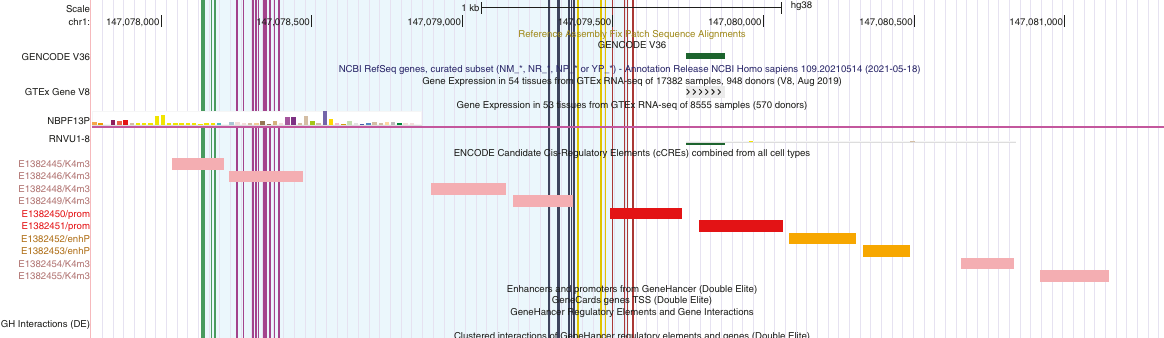
Fig. 2 Genomic features visualized relative to transcription factor binding site EH38E1382446 that was identi fi ed in the list of top 20 DMCs. The 1432 base-pair region including 35 hypomethylated DMCs is highlighted in blue. Vertical bars indicate individual DMCs that were identi fi ed. The 15 DMCs that were identi fi ed within EH38E1382446 are highlighted in purple. 4 DMCs highlighted by green bars are mapped to DNase-H3K4me3 EH38E1382445, navy bars (7 DMCs) are mapped to DNase-H3K4me3 EH38E1382449. Yellow bars show 4 DMCs that are not annotated to any known genomic features, and red bars show 4 DMCs that are mapped to promoter E1382450. (Image obtained from UCSC genome browser for hg38, region chr1:146,956,350-147,200,349).